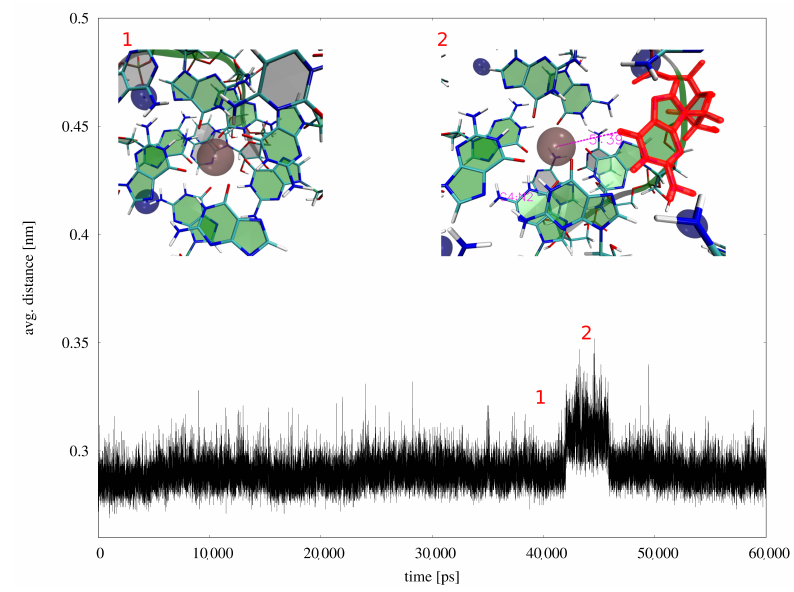
Figure A3. The stability assessment of the seq1 quadruplex, as expressed by the average distance between K + and the carbonyl oxygens of eight guanines coordinating the ion. Inlet 1 (corresponding to the simulation time labelled on the chart at 40 ns of the simulation)—the stable GQ core structure. Inlet 2 (and label 2 on the chart)—the lateral guanine (red) diffused away from the central K + (dark-pink sphere), which was reversed after ∼ 3 ns. See the text of Appendix B.2 for a detailed explanation.